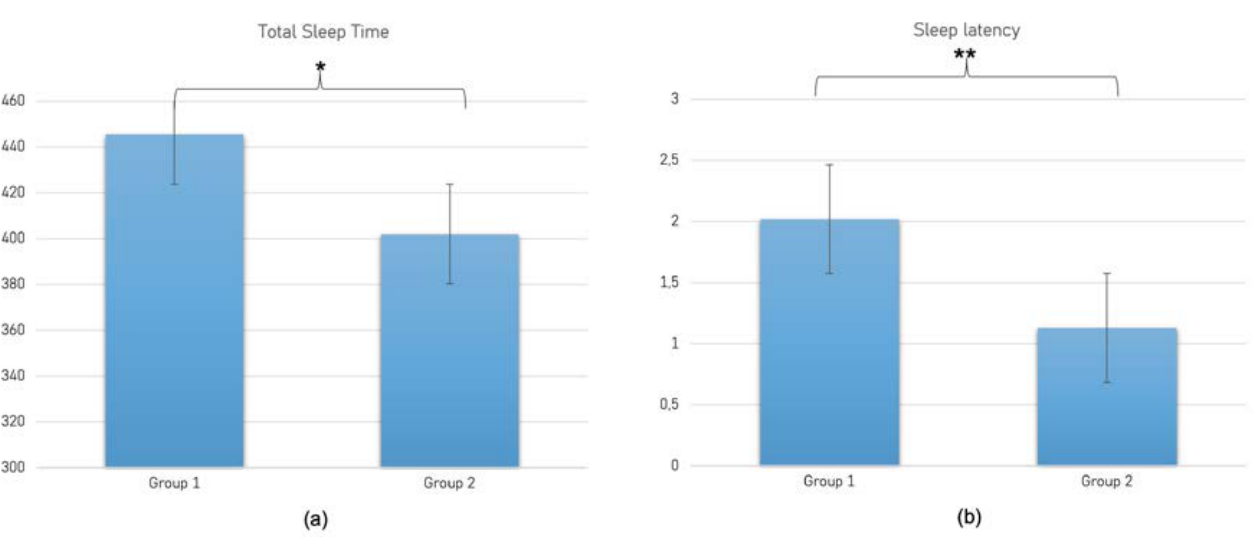
Figure 3. Comparison between Group 1 (prisoners) and Group 2 (controls) with respect to Total Sleep Time (panel ( a )) and Sleep Latency (panel ( b )) as measured by means of actigraphy; * p = 0.031; ** p < 0.001.